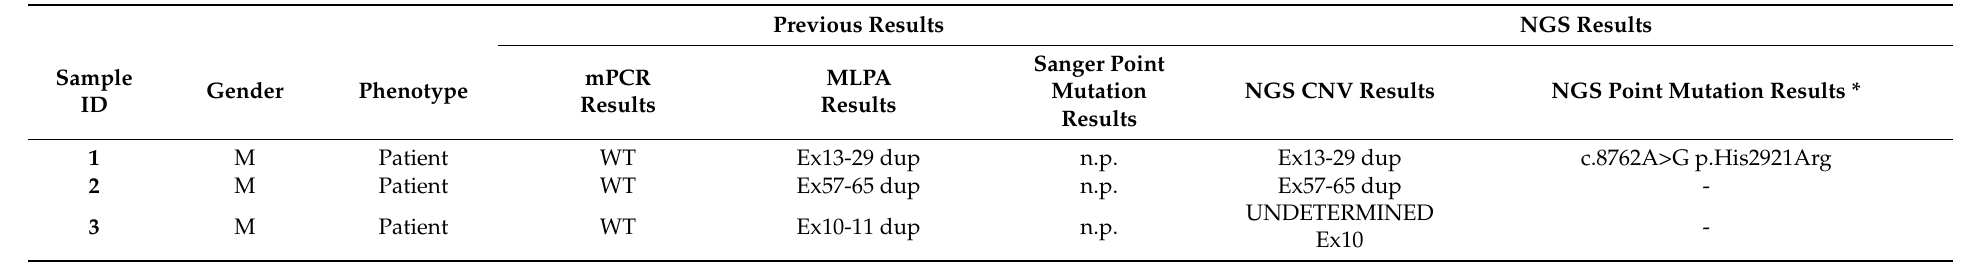
Table 2. Comparison of the results found by combining MLPA and multiplex-PCR, or by Sanger sequencing approaches (“Previous results”), and those obtained by next generation sequencing (“NGS results), in the 40 subjects enrolled in this study. For the CNV analysis four samples were “REJECTED” and five samples showed “UNDETERMINED” regions, due to